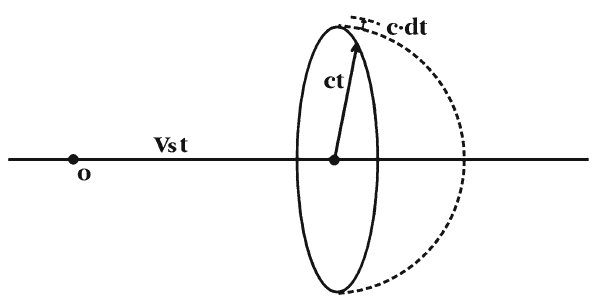
Fig. 9 The photon layer. The photons which will arrive at the center of the bubble after time t are laying on a shell with radius R = ct and thickness cdt . The distance between the center of the bubble and the center of the shell is v s